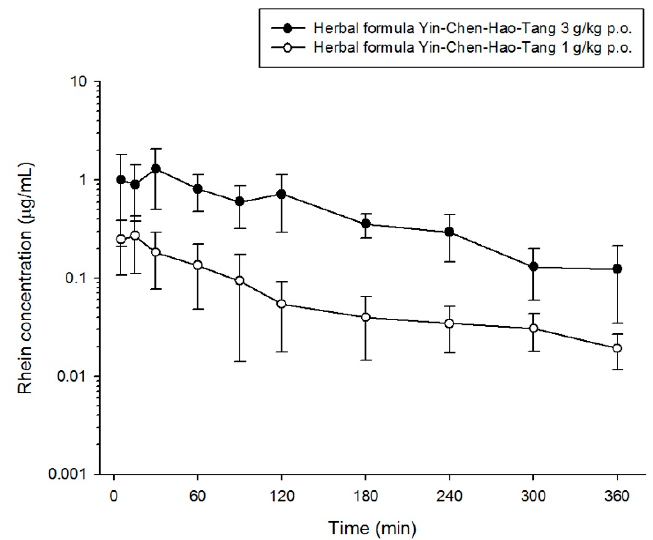
Figure 5. Concentration-time profile of rhein in rat plasma following oral administration of different dose of herbal formula (1 g/kg p.o. or 3 g/kg p.o. Yin-Chen-Hao-Tang).